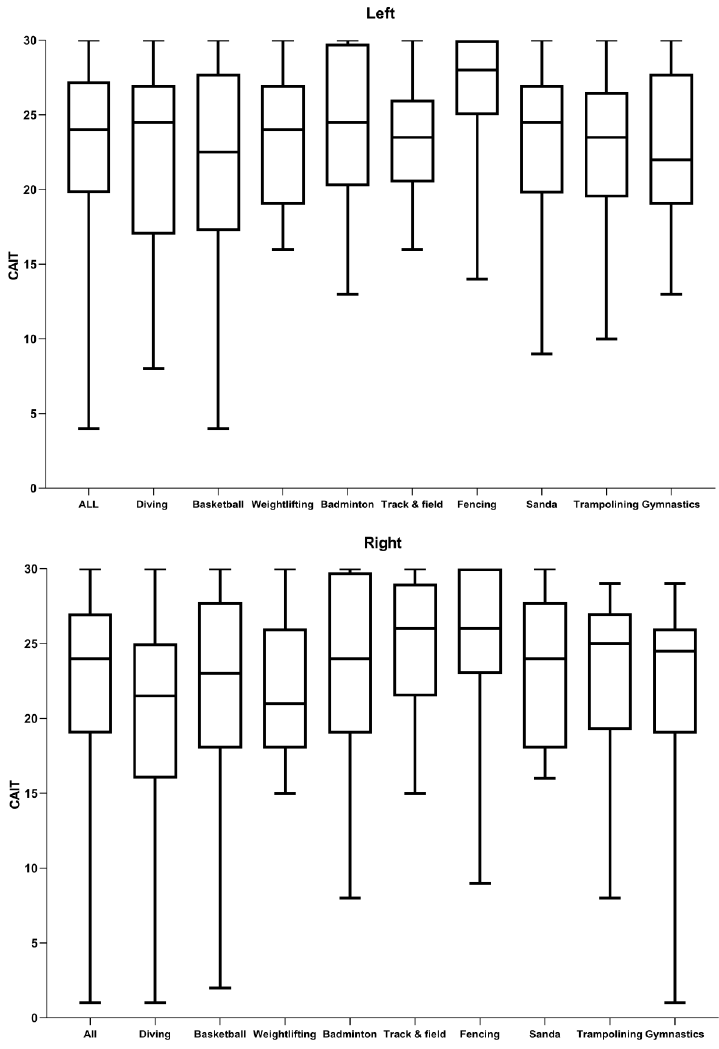
Figure 4. The CAIT value for each sports team. Table 5. The positive rate of anterior drawer tests and talar tilt tests for CAI athletes.